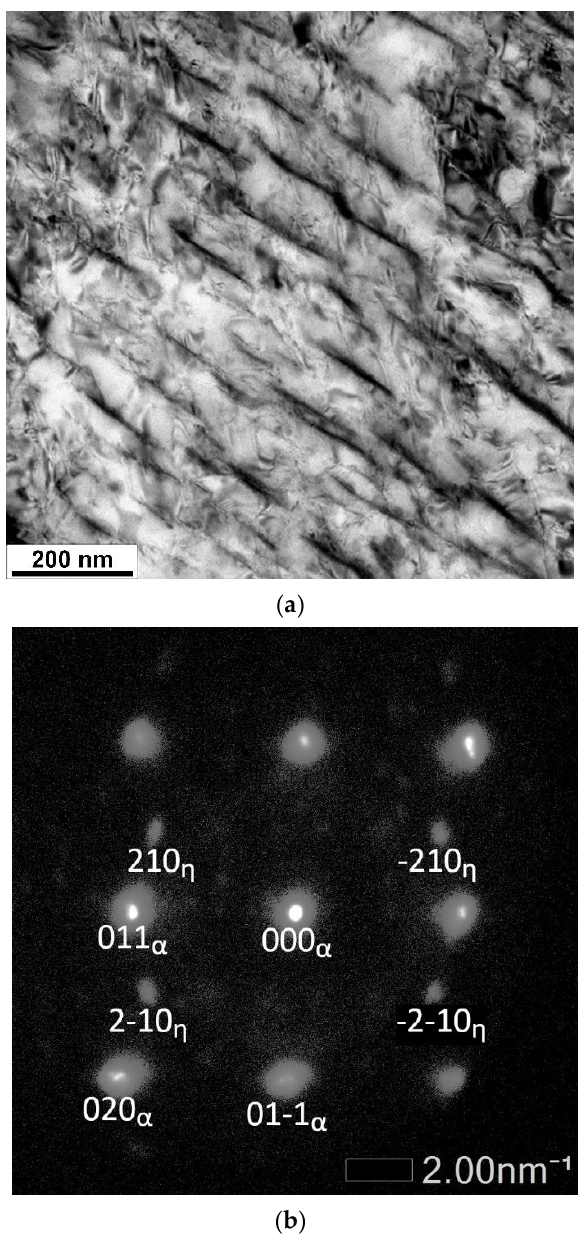
Figure 6. TEM micrograph of the η -Fe 2 C carbide ( a ) in steel B tempered at 200 °C and SAED pattern with zone axis [100] ( b ). Table 5. Retained austenite content (RA) determined by XRD measurements.